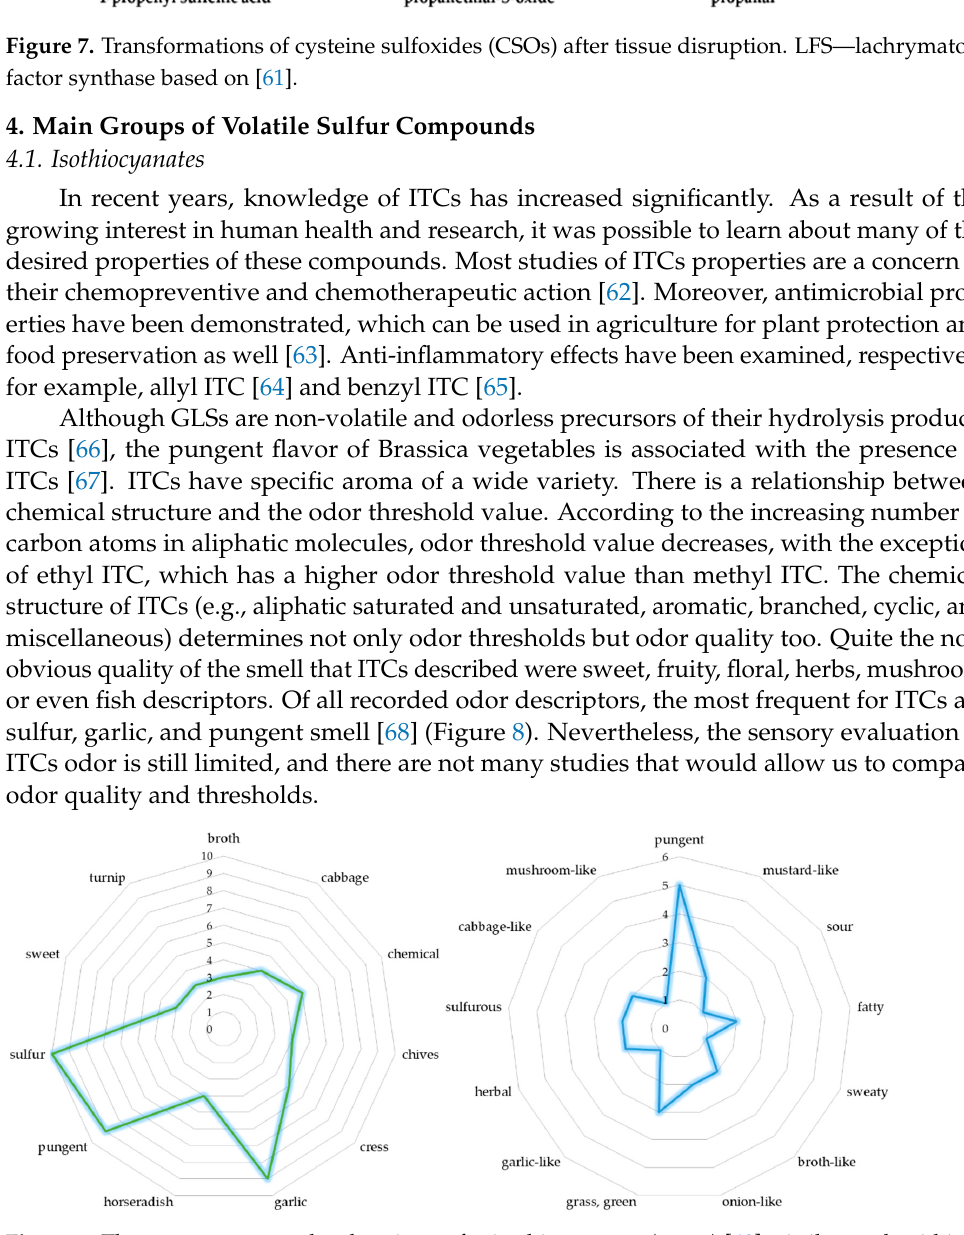
Figure 8. The most common odor descriptors for isothiocyanates (green) [68], nitriles, and epithionitriles (blue) [26,61–64] found in